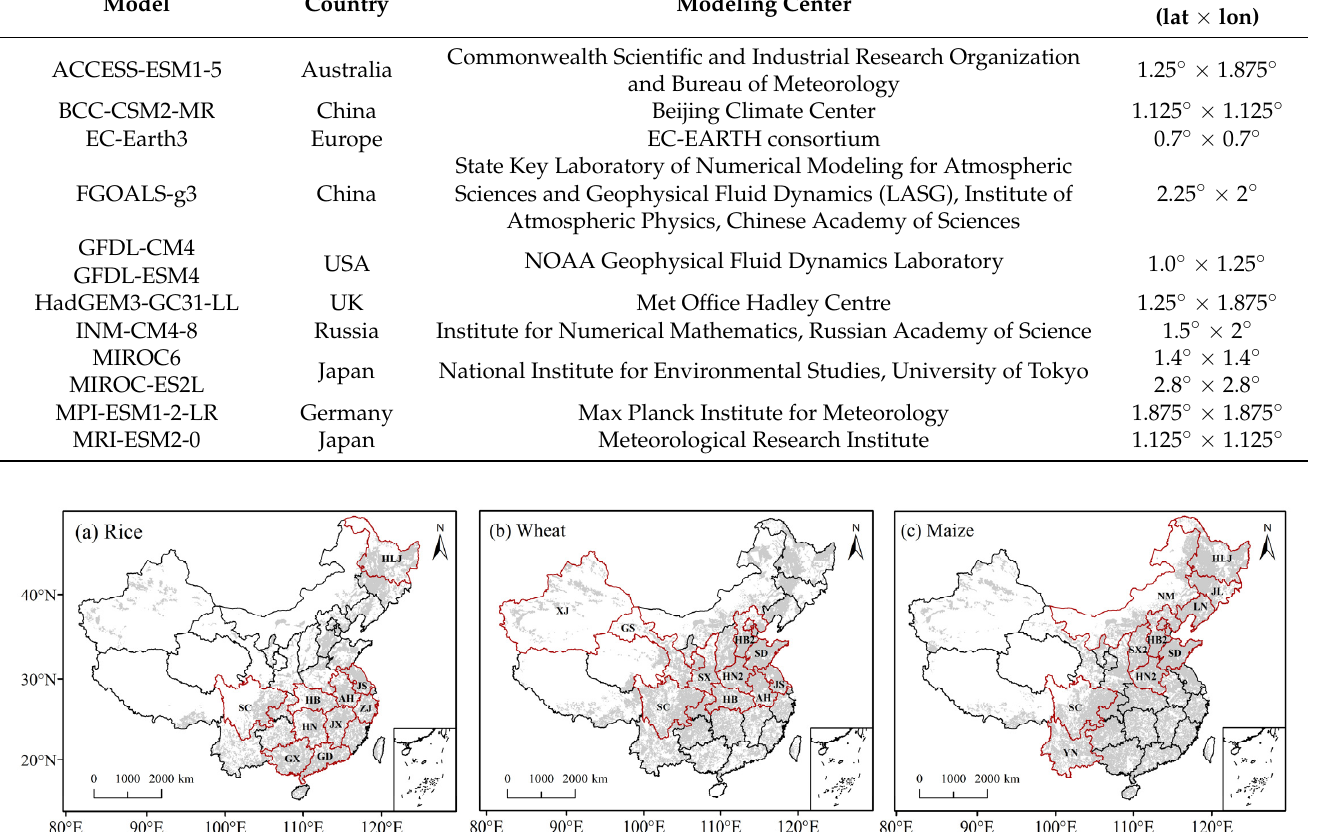
Figure 1. Main crop-producing provinces for ( a ) rice, ( b ) wheat, and ( c ) maize, respectively. The grey-